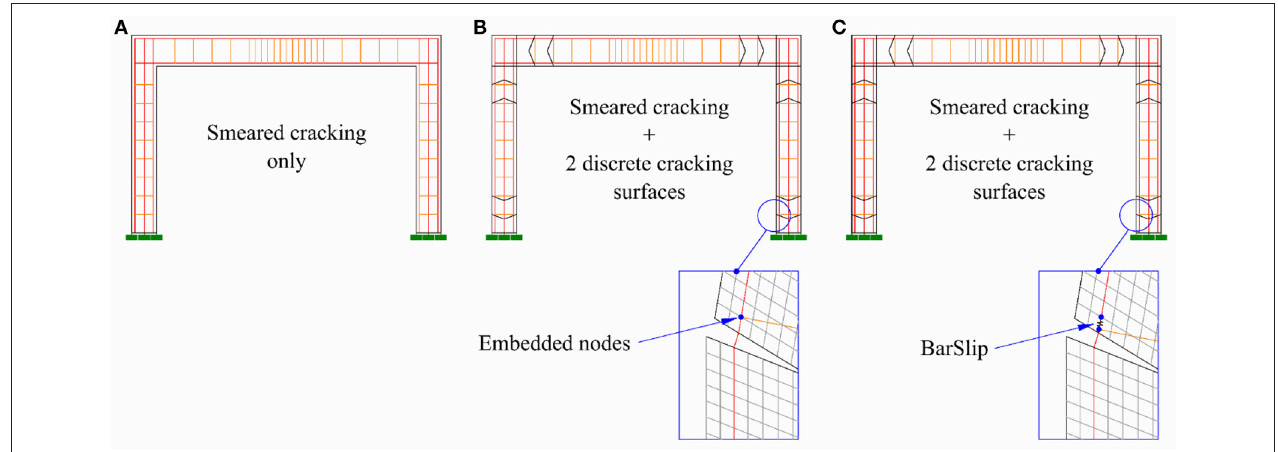
FIGURE 6 | Illustration of (A) FES model, (B) FEB 1 model, and (C) FEB 2 model.